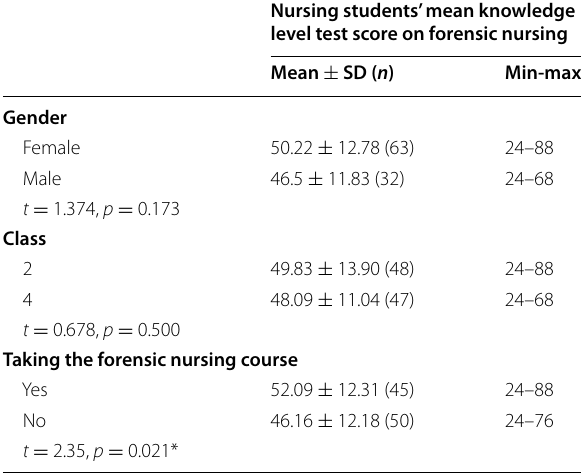
Table 3 The mean knowledge level test scores on forensic nursing according to gender, class, and status of taking